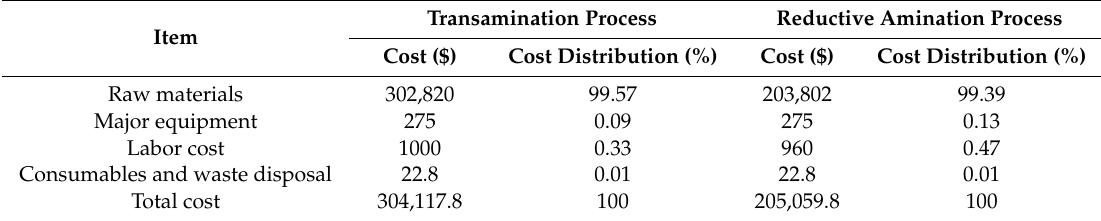
Table 9. Cost distribution for chiral amine production by each conversion